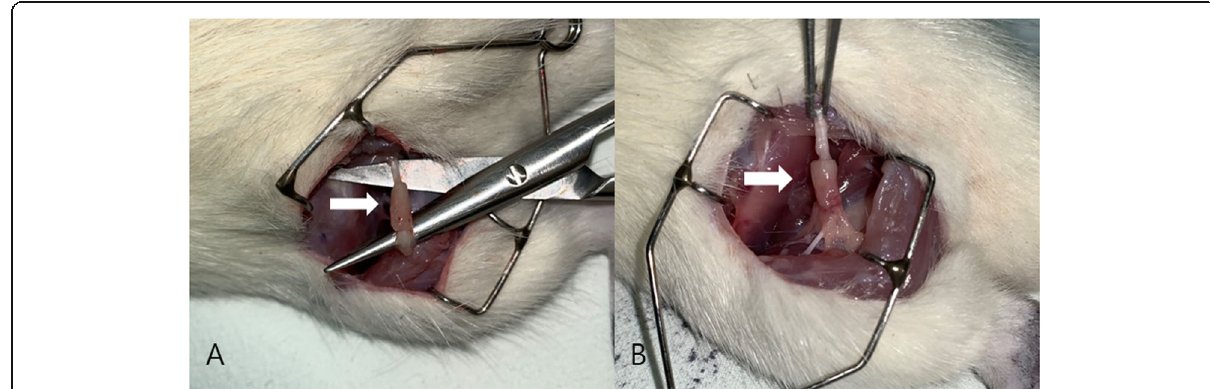
Fig. 5 Harvesting the sciatic nerve. ( A ) Representative sciatic nerve of group C at 2 weeks. ( B ) Representative sciatic nerve of group C at 4 weeks. The collagen membrane is observed to be maintained at both periods (arrow)